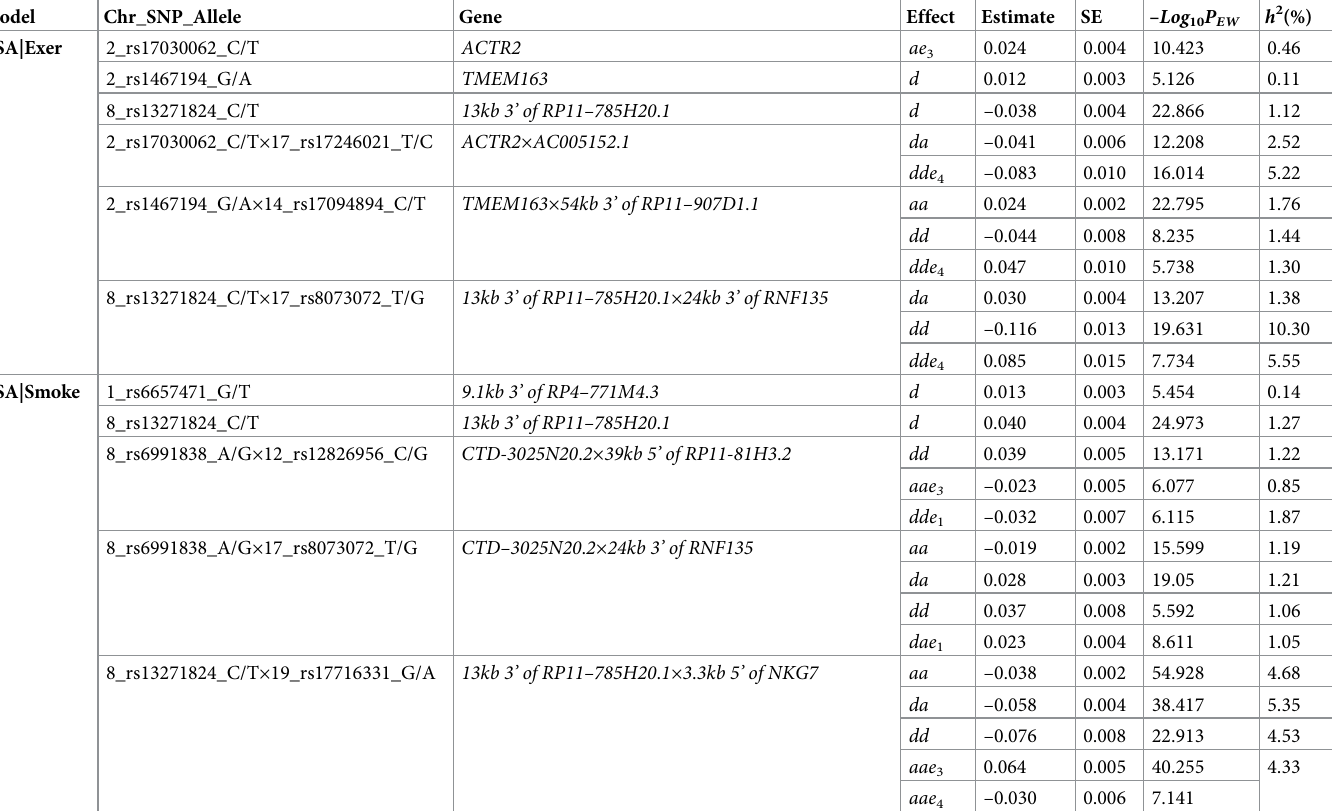
Table 3. Predicted genetic effects of individual and epistasis loci with standard error, significance, and heritability for BSA associated loci identified only in the life- style cofactor models.